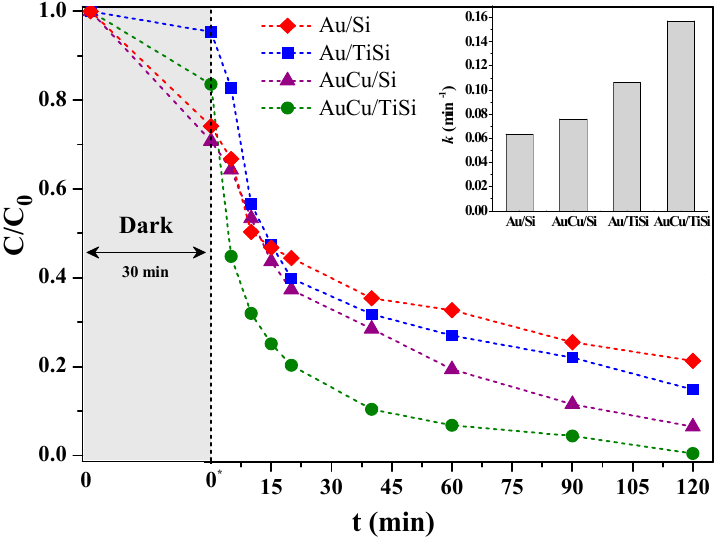
Figure 1. Performances of adsorption and methylene blue (MB) photodegradation on mesoporous silica and titania-silica-based catalysts before and under UV irradiation, with the calculated kinetic constants (inset).